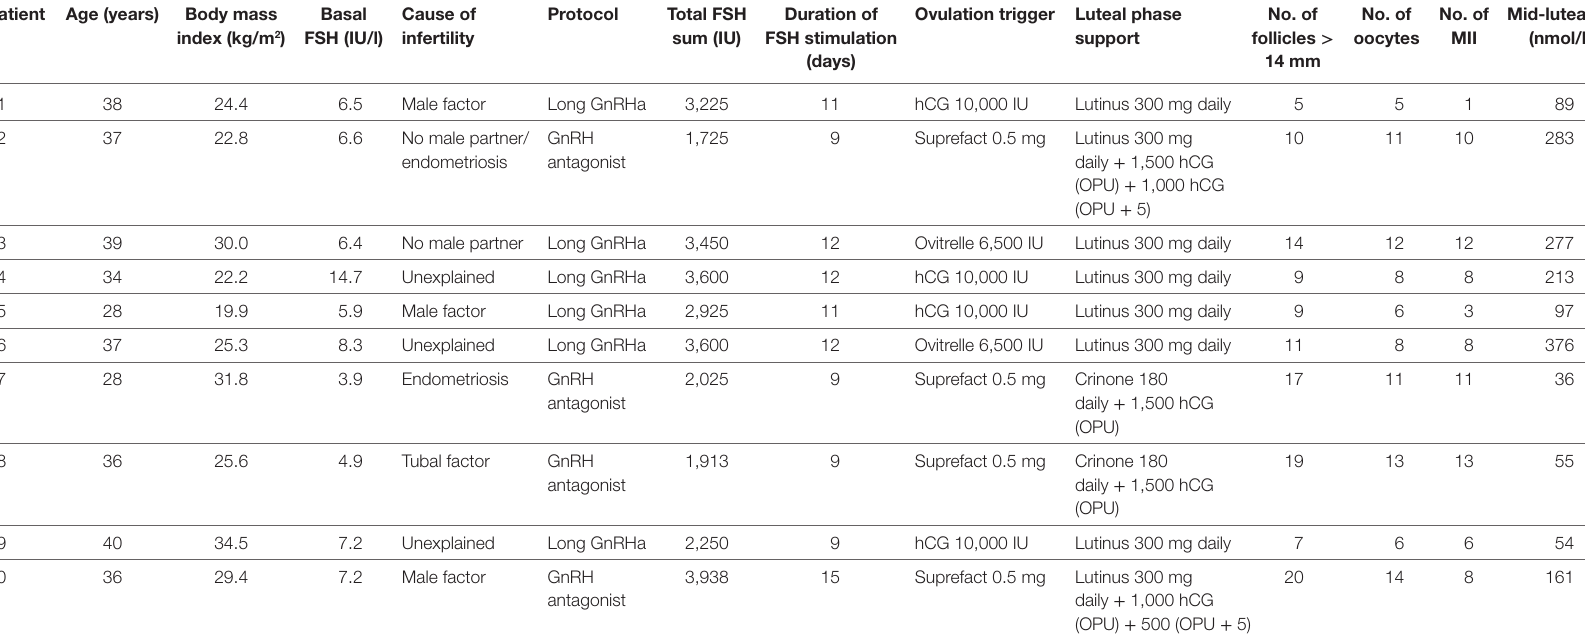
Table 1 | Description of demographic data, ovarian stimulation, luteal phase support, and progesterone levels in study patients. Patient age